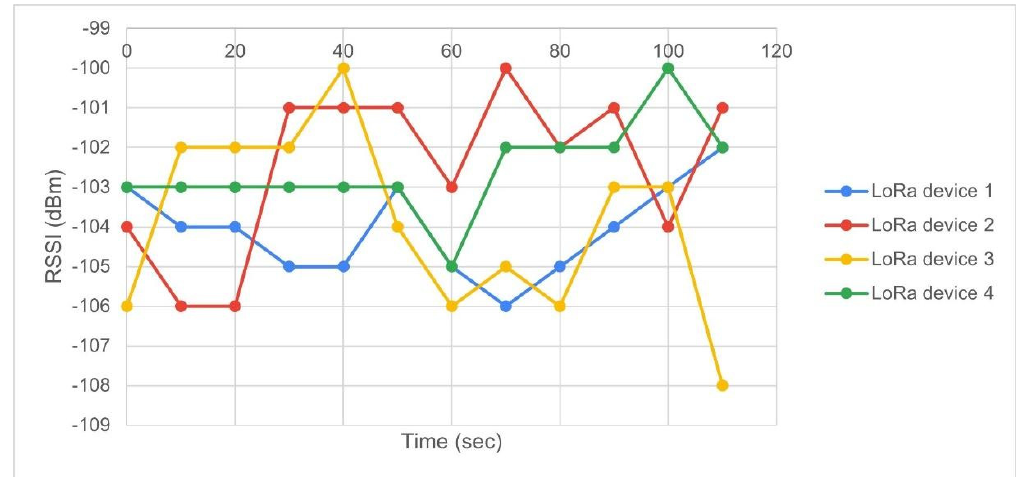
Figure 10. RSSI values for the best setting (spreading factor (SF) = 7, BW = 125 kHz, coding rate (CR) = 4/6) in Experiment 3.